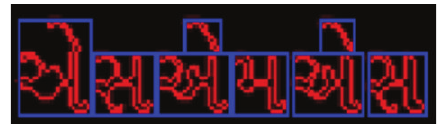
Figure 7: Computation of rectangularity of component on Gujarati script showing blue: rectangular box.